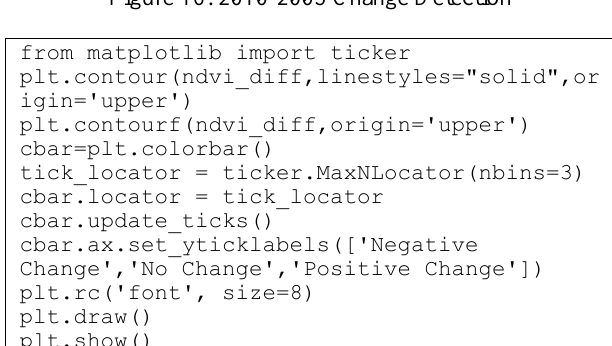
Figure 16. 2010-2005 Change